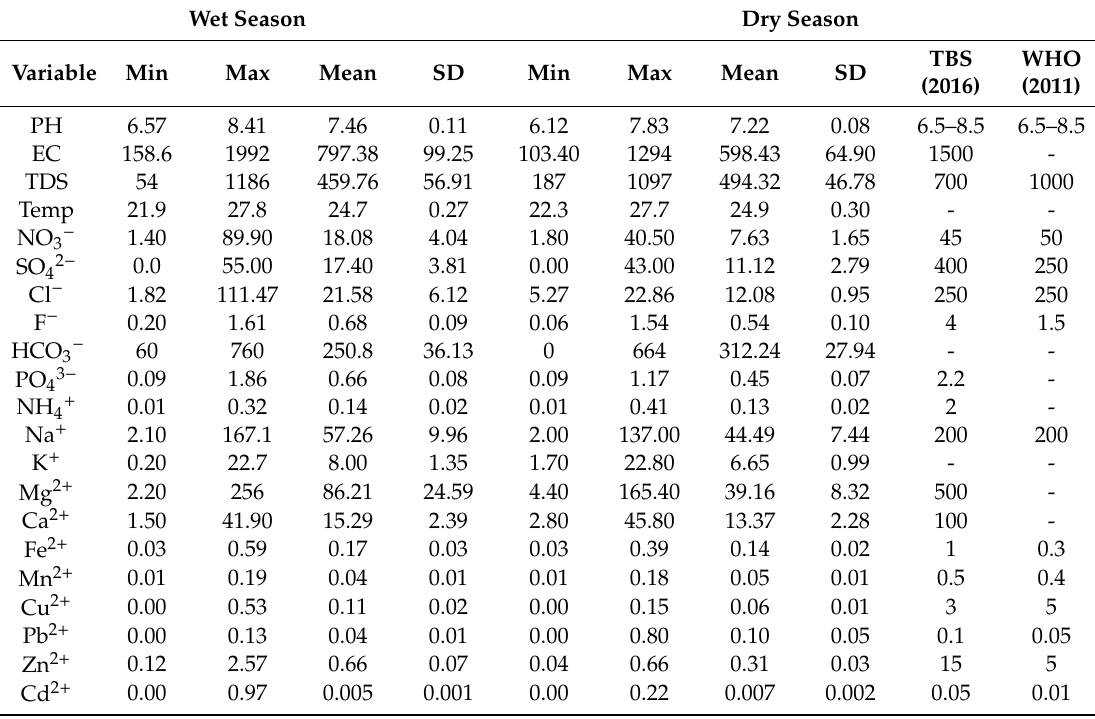
Table 1. Summary statistics of measured variables in the sampled groundwater compared with drinking water